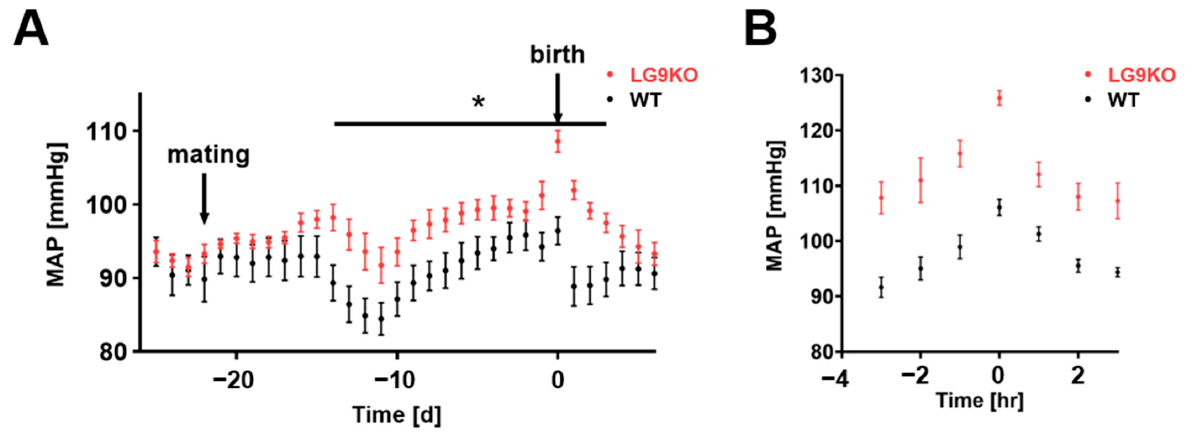
Figure 1. Time course of blood pressure values with and without hyperuricemia: ( A ) Blood pressure diagram of WT (black, n = 7) and LG9KO (red, n = 8) animals during gestation. Each point represents a 24 h average of the mean arterial pressure ± SEM. At day eight of gestation, the mean arterial pressure of the LG9KO animals’ increases compared to the WT group; this difference disappears at day 5 after birth. ( B ) One-hour averages (indicated timepoint ± 30 min) of peripartal blood pressure. A difference of 19 mmHg was observed between LG9KO and WT groups at the time of birth (t = 0). * p < 0.05.